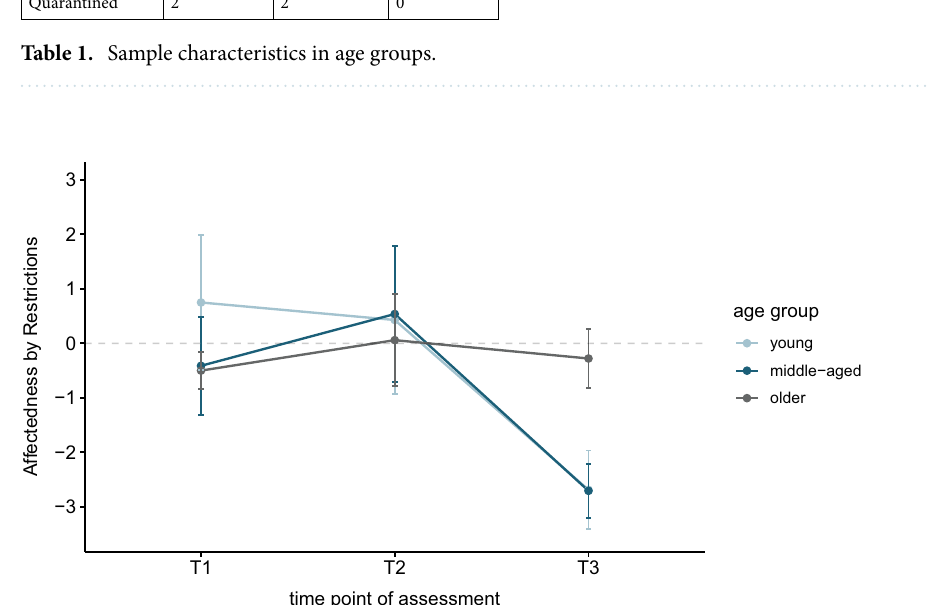
Figure 1. Rated affectedness by the restrictions in the different age groups over time. We used the reported impact of COVID-19 and related restrictions on the communication with friends and family, the physical and psychological health, sleep, nutrition and sporting activities. Participants were asked to rate the impact of COVID-19 on each of these queried domains, ranging from very negative impact (− 2) to very positive impact (+ 2). The affectedness score was then calculated as the sum across items and could range from − 14 to + 14. Negative values represent a negative reported impact, positive values a positive reported impact regarding the affectedness by the restrictions. A value of 0 would indicate no affectedness by COVID-19. Error bars depict 1 standard